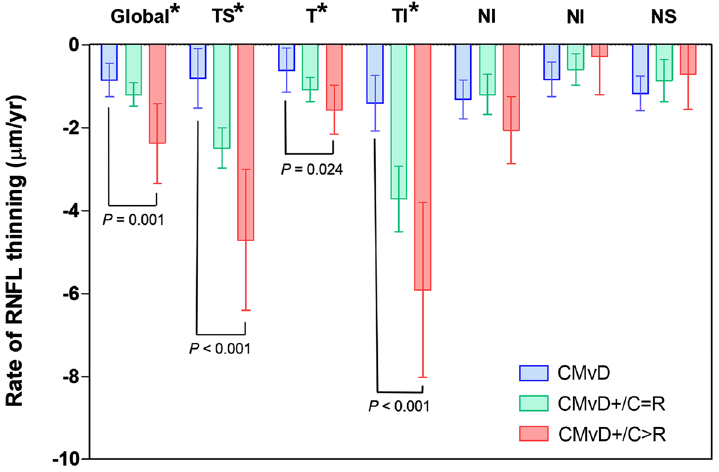
Figure 2. Comparison of the rate of retinal nerve fiber layer (RNFL) thinning globally and in six circumpapillary sectors. Asterisks indicate statistically significant differences between groups. Error bars indicate 95% confidence intervals.